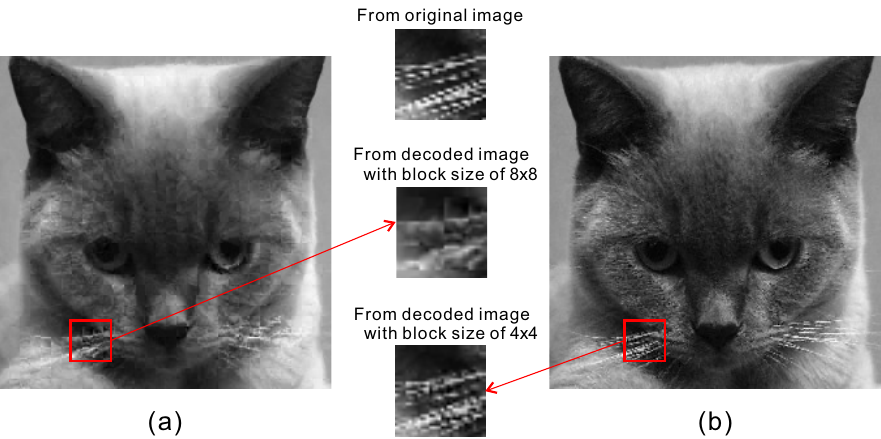
Figure 6. Cat image of size 256 × 256 with 8 × 8 range block fractal encoding and ( a ) decoded with 8 × 8 range block size at the 20th iterations, and the associated zoom-in image block of the eye of the Cat in ( b ) the same image decoded with 4 × 4 range block size at the 30th iterations, where a zero matrix initial image are adopted in both decoding